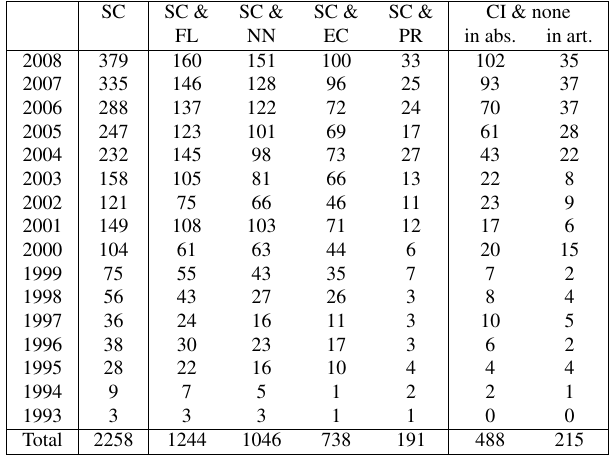
Table 1. Articles in Scopus containing the term “Soft Comput- ing”.